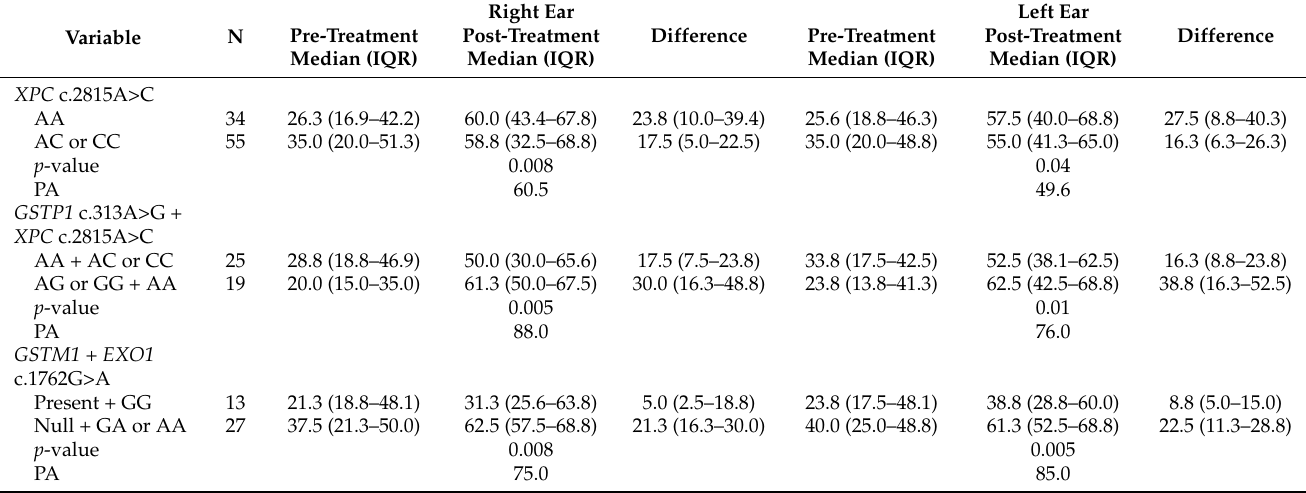
Table 4. Significant associations of single nucleotide variants with high-frequency average thresholds (3, 4, 6, and 8 kHz) related to cisplatin-based